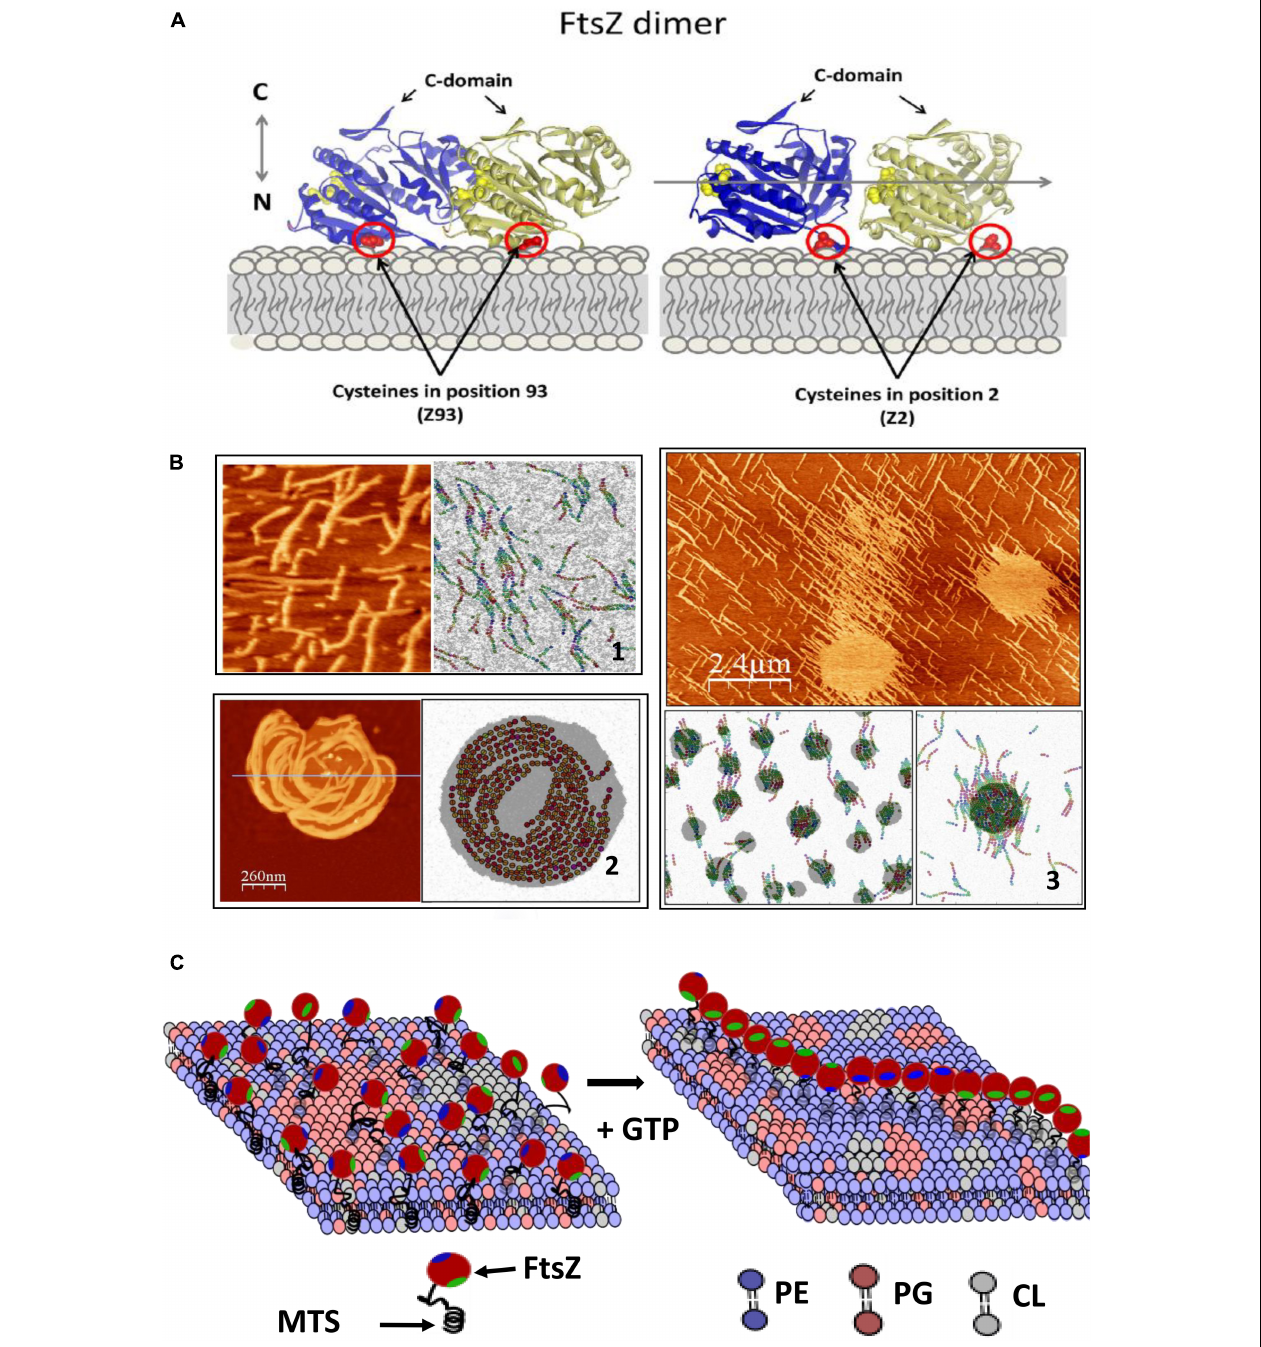
FIGURE 2 | FtsZ activity on the lipid membrane. (A) Shows how E.coli FtsZ monomers are oriented when attached covalently to a maleimide lipid (DSPE-MAL) in the bilayer through a cysteine placed in different positions. (B) Shows 3 examples of structures observed with AFM and snapshots of MC simulations of the model that describes the system including three terms: the dynamic interactions between protein monomers, the interactions between lipid components, and a mixed term considering protein–lipid interactions. Including torsion of the monomers within the filament in the model is necessary to account for the observed filament shapes. (1) Shows mutant E93C above lipid segregation temperature; (2) shows mutant F2C below lipid segregation temperature and (3) mutant E93C at higher DSPE-MAL concentration (adapted from González de Prado Salas et al., 2015). (C) Shows a schematic illustration of how polymerization of FtsZ could affect the membrane. The association is through a membrane targeting sequence (MTS) localized in the C-terminal region (green). The components are the main lipids present in the E.coli inner membrane (phosphatidylethanolamine, PE, phsophatidylglycerol, PG and cardiolipin, CL). Tension created by filament torsion and preferential curvature restrictions upon surface confinement could affect lipid